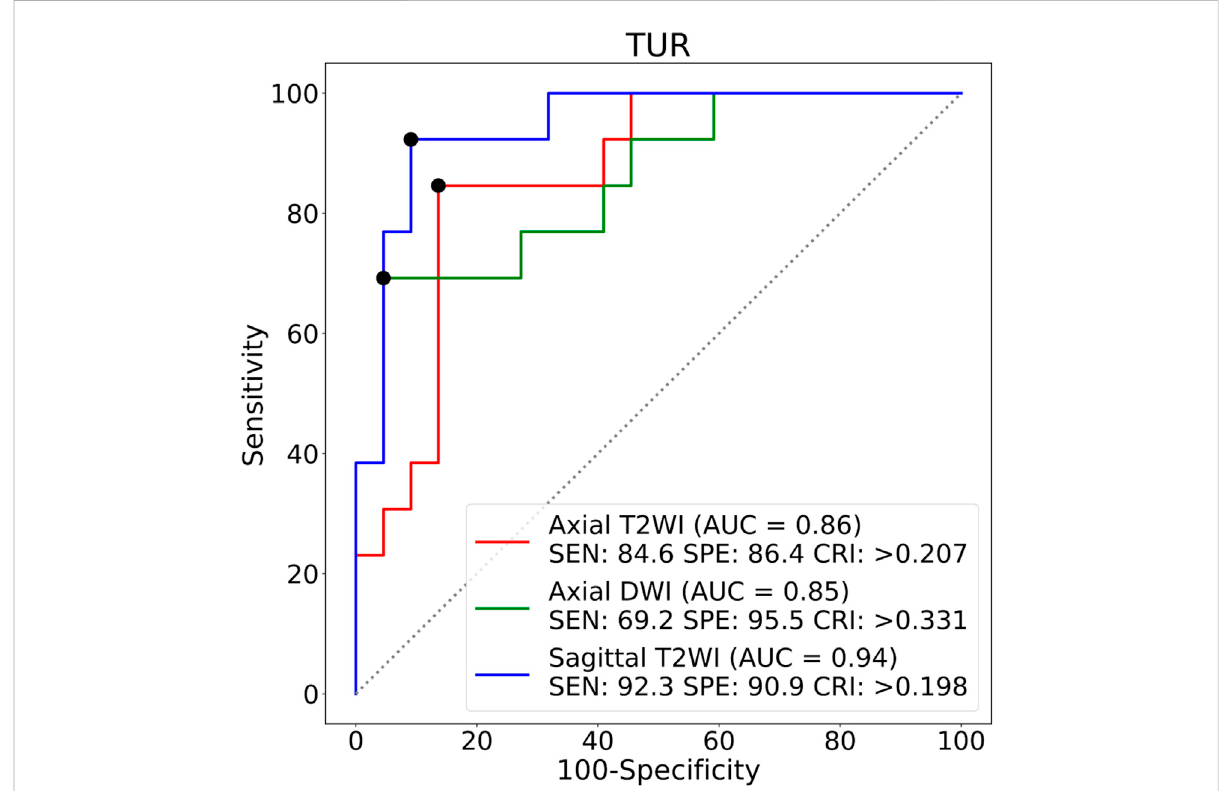
FIGURE 6 ROCs on three different MRI sequence slices. SEN:Sensitivity, SPE:Speci fi city, CRI:Criterion.